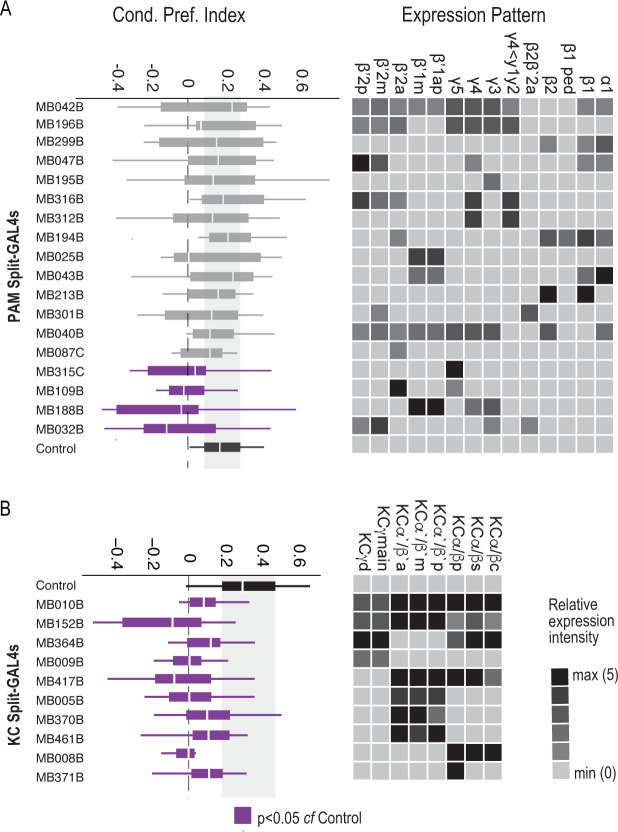
Requirement of PAM DANs and Kenyon cells in formation of alcohol-associated preference.(A) Inactivation of subsets of PAM DANs during both acquisition and retrieval resulted in significant decreases in preference for alcohol associated cues χ2(18)=30.81, p=0.03. Four of the 18 specific PAM Split-GAL4 lines which predominately express in the medial aspect of the MB resulted in significant decreases as compared to control lines (MB315C, MB109B, MB188B, and MB032B). (b) Inactivation of subsets of Kenyon cells during both acquisition and retrieval using 10 specific Kenyon cell Split-GAL4 lines. All 10 lines resulted in significant decreases in preference for alcohol associated cues. χ2(10)=27.97, p=0.002. Kruskal Wallis was used to compare mean and variance with Dunnett’s Posthoc test compared to control. Purple fill indicates p<0.05.